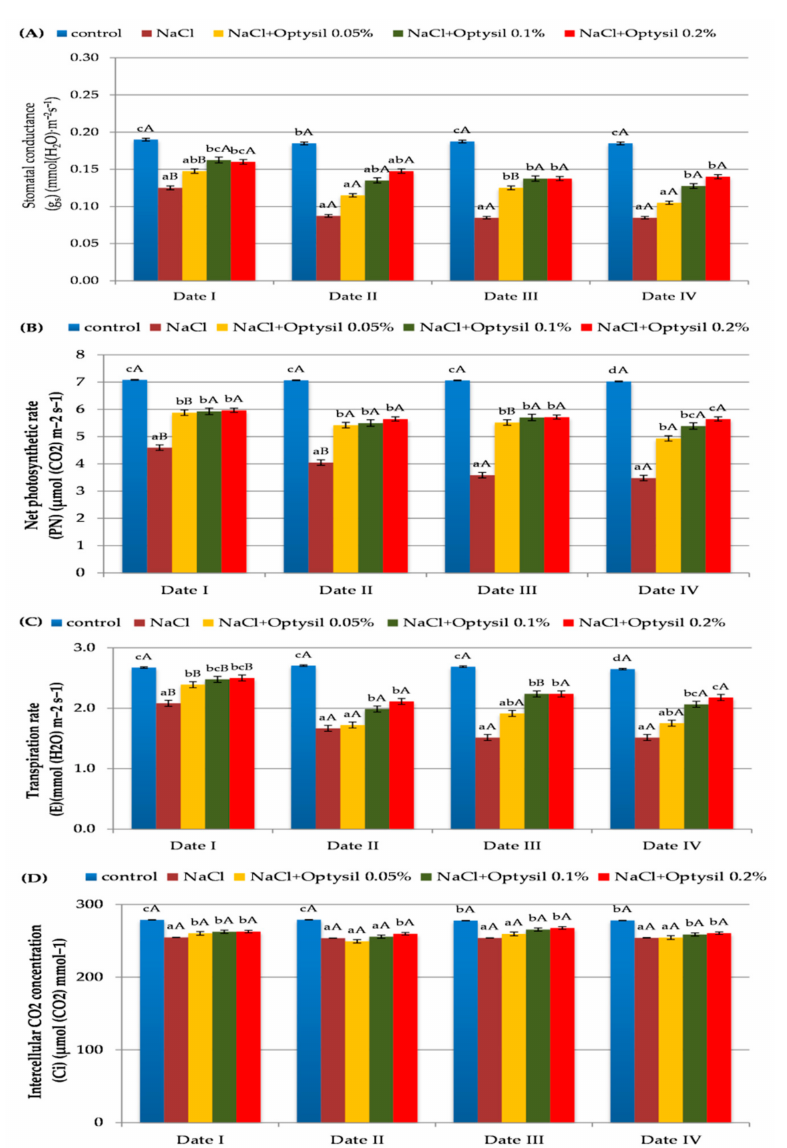
Figure 3. The effect of factors of experiment and measurement date on gas exchange parameters in oat plants (Date I and Date II, 2 and 7 days after first Si application; Date III and Date IV, 2 and 7 days after second Si application). Statistical data are expressed as mean ± SD values. Capital letters show significant differences between the means in the measurement dates, and lower case letters show significant differences between the means at next measurement dates ( p = 0.05).